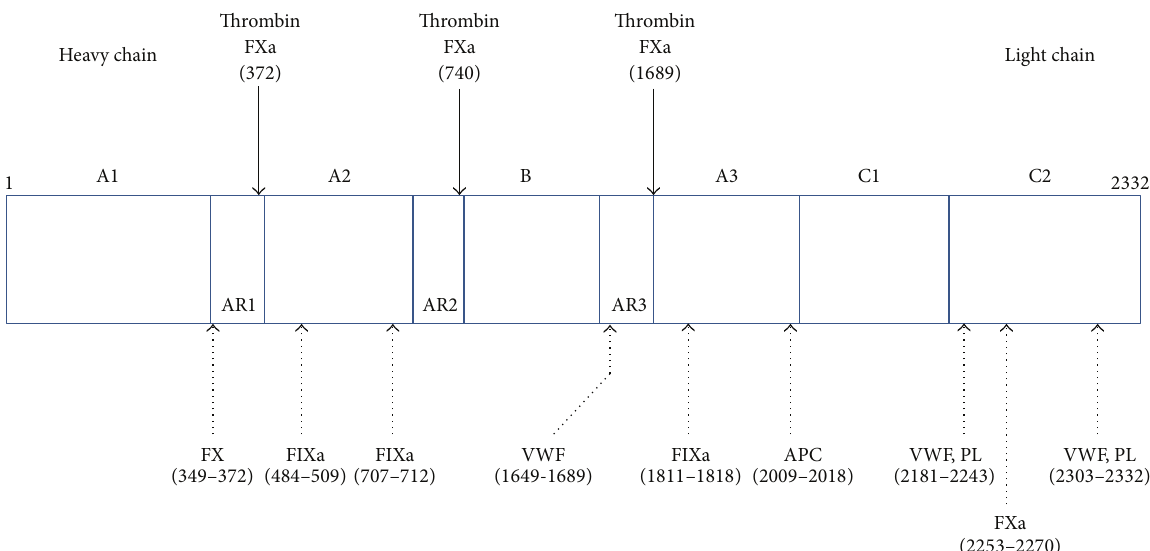
Figure1:StructureofthecoagulationfactorVIII(FVIII)molecule.Thenumbersindicateaminoacidpositions.PlasmaFVIIIisaheterodimer composed of a heavy chain (domains A1, A2, and B) and a light chain (domains A3, C1, and C2). Noncovalent binding of FVIII with von Willebrand factor (VWF) protects circulating FVIII from being inactivated by activated protein C. The binding sites of VWF, phospholipids (PL), and other coagulation factors (activated factor IX [FIXa], factor X [FX], and activated FX [FXa]) are also indicated. FVIII is cleaved and activated by thrombin and FXa at residues 372 and 740 within the heavy chain and at residue 1689 within the light chain. Inhibitors impair FVIII activation by interfering with thrombin-catalyzed cleavage or FVIII interactions with VWF, FIXa, FX, and PL. AR: acidic region.